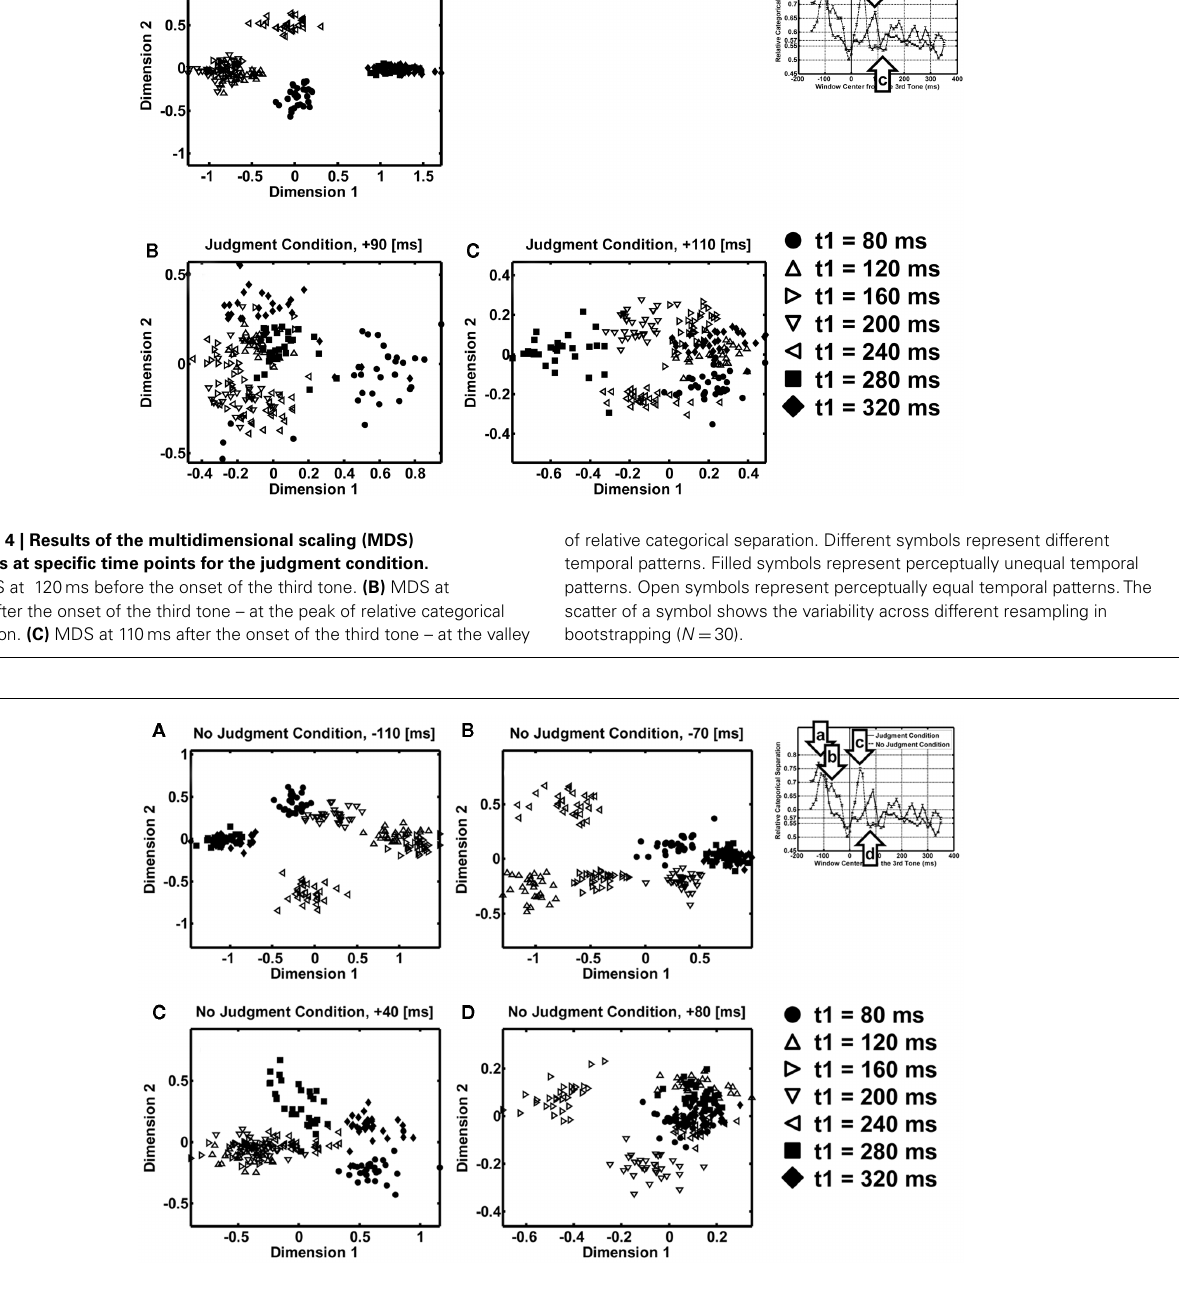
FIGURE 5 | Results of the multidimensional scaling (MDS) analyses at specific time points for the no-judgment condition. (A) MDS at 110ms before the onset of the third tone. (B) MDS at 70ms before the third tone. (C) MDS at 40ms after the third tone – at the peak of the relative categorical separation. (D) MDS at 80ms